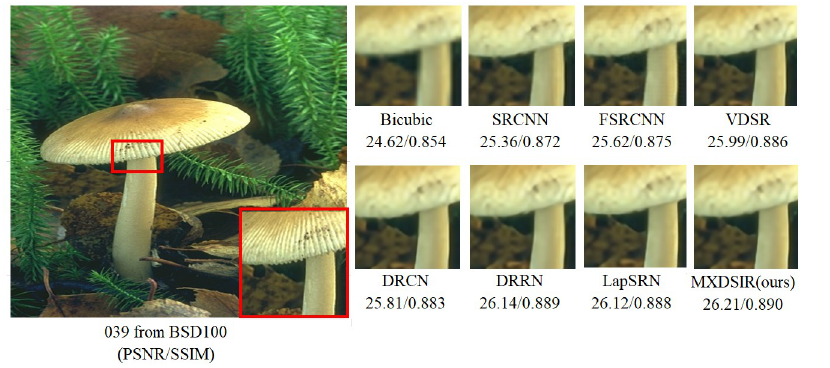
Fig 4. Visual performance of images with 4 × enlargement factor of image 039 from BSD100 dataset.